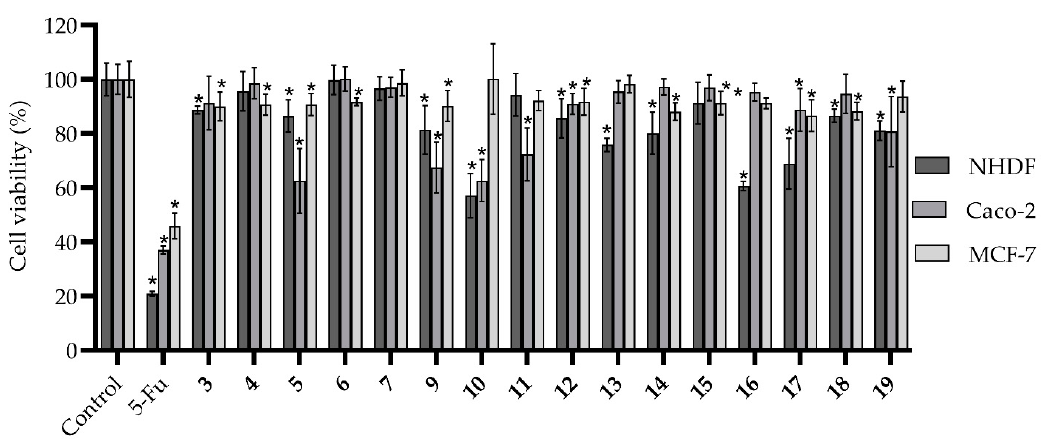
Figure 3. In vitro effects of bis-thiobarbiturates 3–7 and 9–19 and 5-FU on cell viability of non-tumor cell lines of normal human dermal fibroblasts (NHDF), and human adenocarcinoma tumor cell lines of colorectal (Caco-2) and breast (MCF-7), at the single concentration of 30 µM. Results are expressed as average values ± standard deviation of at least two independent assays performed in quadruplicate. * p < 0.05 versus the negative control by Student’s t -test.